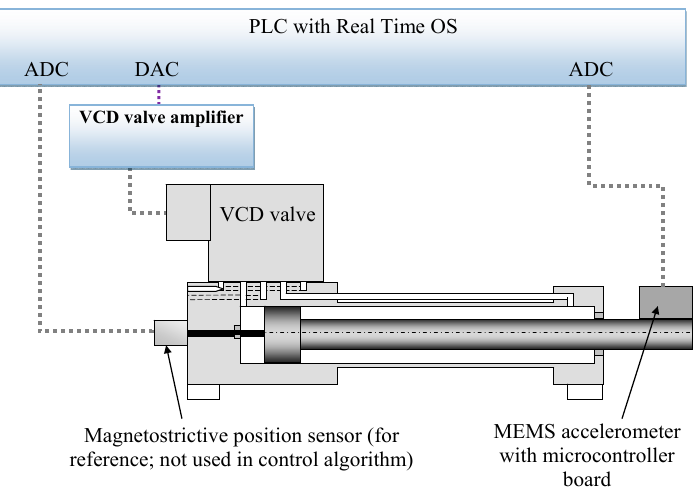
Figure 7. Control system diagram (test stand).